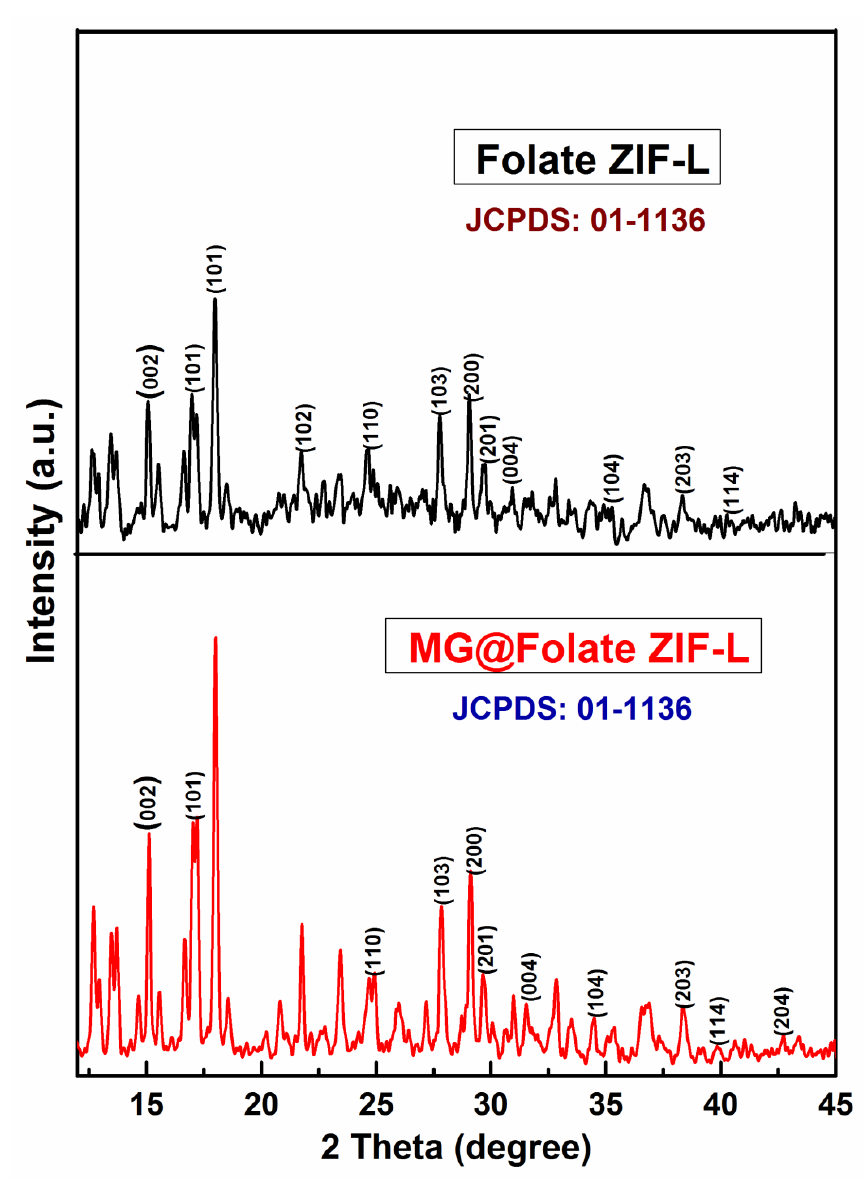
Figure 2. Powder XRD analysis of Folate ZIF-L (black) and MG@Folate ZIF-L